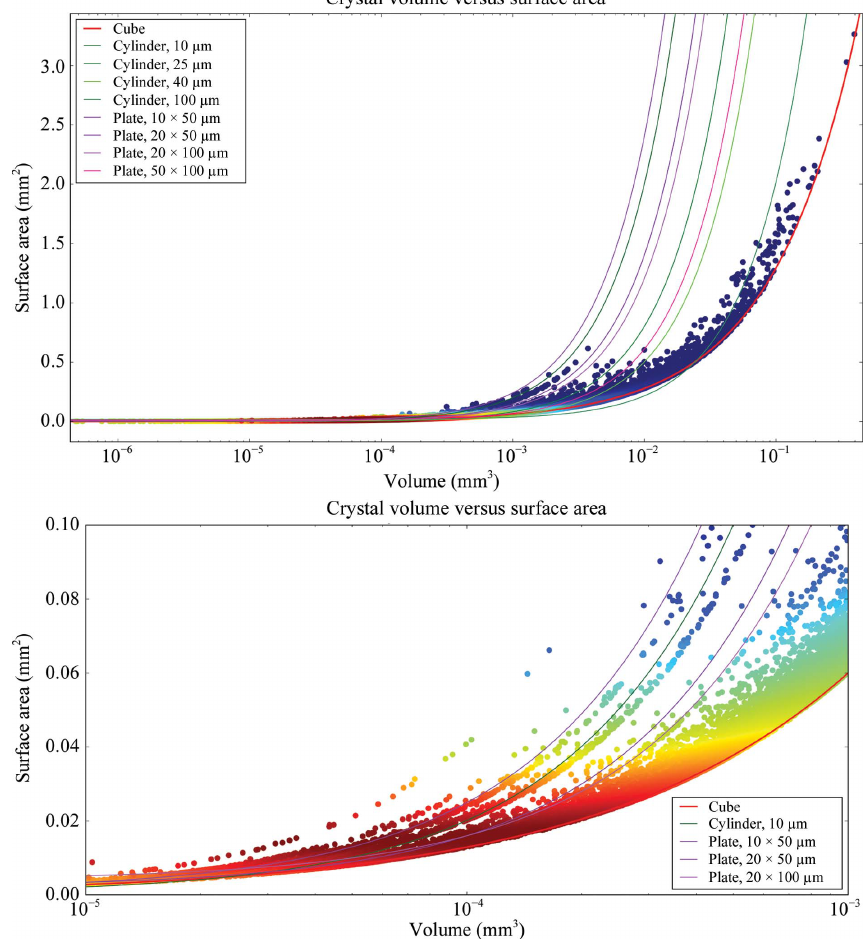
Figure 2 Crystal surface-area-to-volume ratio. The relationship between surface area and volume is shown with lines representing the curves described by different shapes and points coloured by the kernel density estimate (KDE). N = 33 905. The lower panel shows a magnified area with the highest counts. Most crystals are small and have one dimension that is in the 10–30 m m